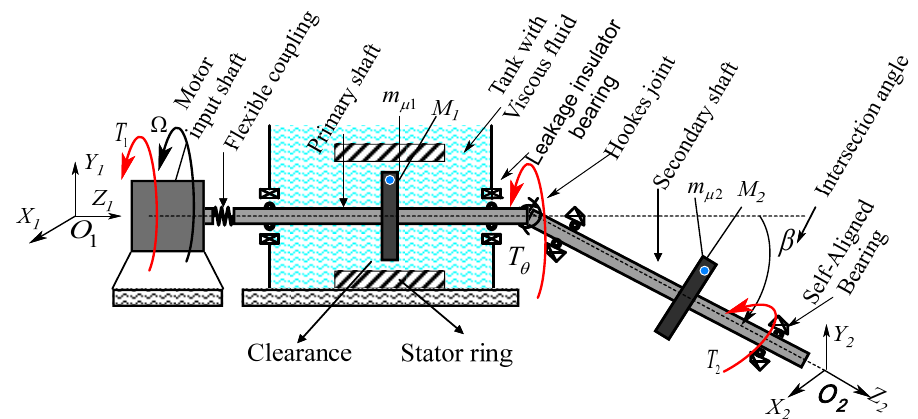
Figure 1. Sketch of the partially immersed Cardan shaft system in a viscous fluid.